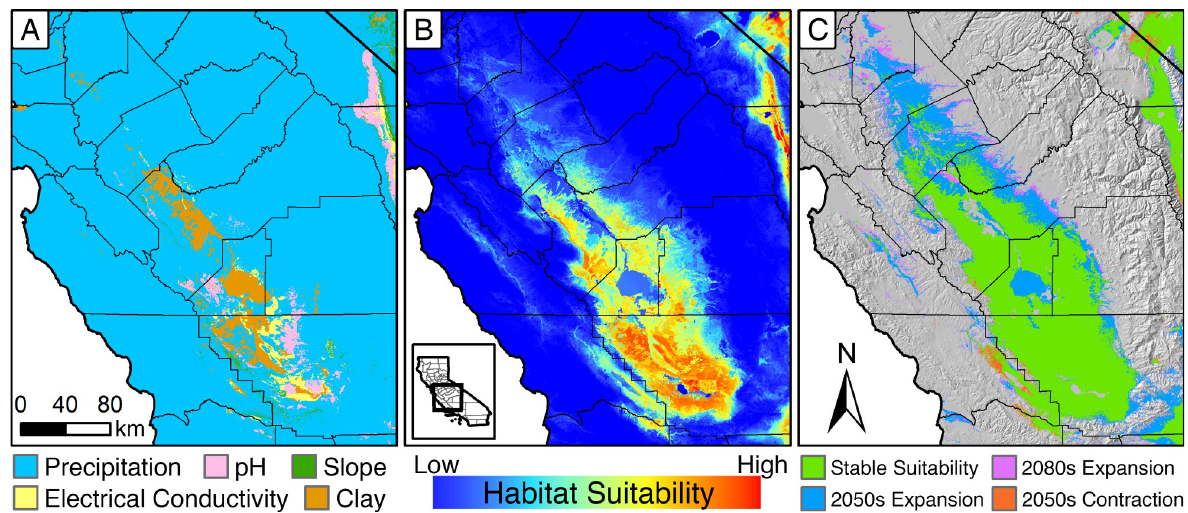
Fig 2. Metrics of habitat suitability for Gambelia sila . (A) Limiting environmental covariates across geographic space for Gambelia sila assessed using the top-performing model of habitat quality and in absence of habitat loss. High precipitation, and resulting high herbaceous vegetation biomass, are the most limiting variables for the lizard (see S3 Table for variable definitions). (B) Continuous ensemble habitat suitability over the geographic range of G . sila . High clay content, acidic, and overly saline soils create pockets of low and non-suitable habitat within the range of the lizard. (C) Projected climate-driven change in suitable habitat for G . sila under a drought scenario (MIROC-ESM, RCP8.5). See S4 Fig for modeled change under four future climate scenarios.